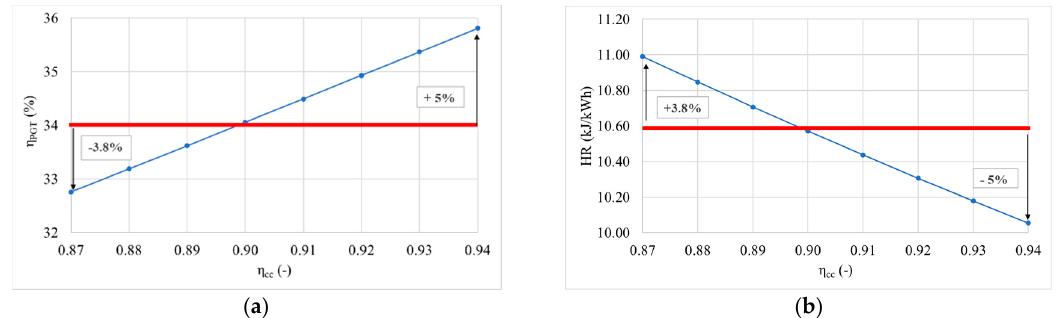
Figure 9. Change of gas turbine cycle outlet parameters in function of combustion chamber efficiency ( a ) gas turbine plant efficiency change in function of combustion chamber efficiency and ( b ) heat rate change of the expanded products at the gas turbine outlet in function of combustion chamber efficiency.